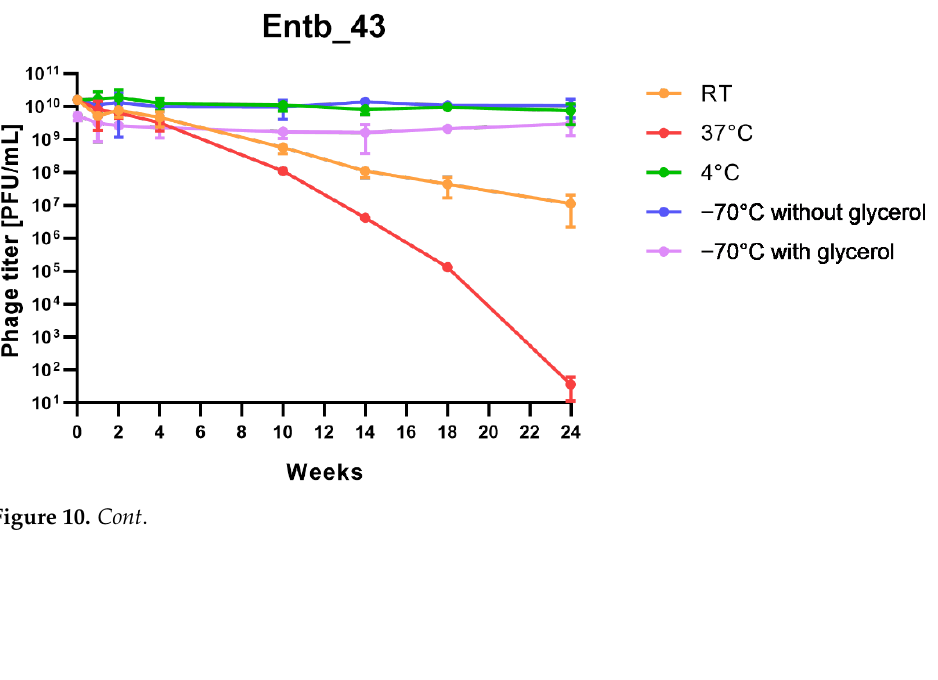
perature and 37 °C. No active phage particles were found in the Entb_45 phage lysate after 18 weeks of storage at 37 °C, whereas the titer of the Entb_43 phage decreased from 10 10 to 10 1 PFU/mL after 24 weeks. Moreover, the thaw-resistance of frozen phage lysates was demonstrated, because after defrosting the same samples five times and refreezing, the phage titers only decreased by about one order of magnitude (Figure 11).